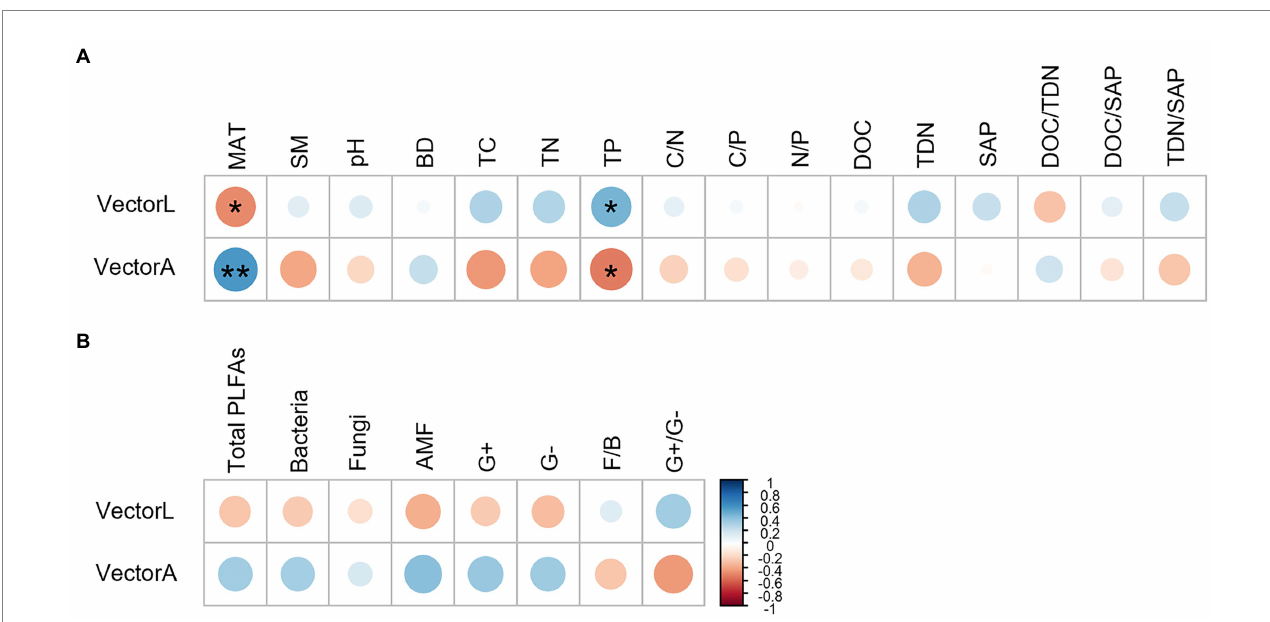
FIGURE 6 Pearson correlation analysis showing the relationship between microbial resource limitation (the vector length and angle) and explanatory variables, including MAT, soil physiochemical factors (A) and microbial community composition (B) . ** p < 0.01, * p <